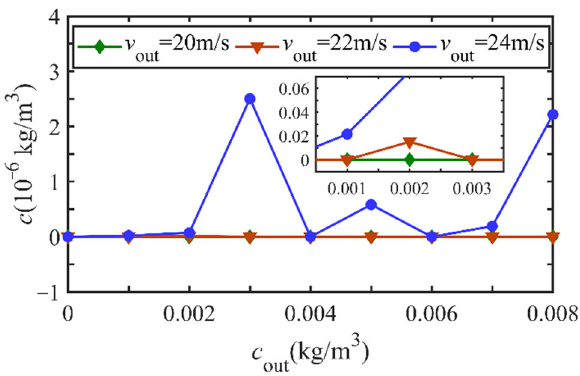
c at the position of  100 L mm for different out